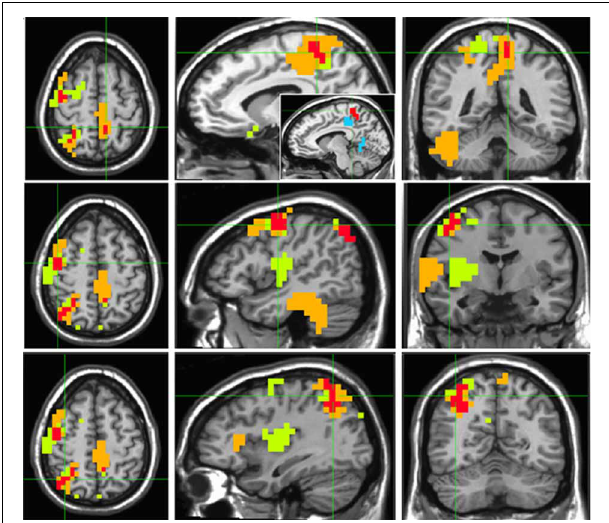
FIGURE 5 | Beamforming source estimates for the overlap between Then vs. Now and There vs. Here contrasts in the theta (4–8Hz) frequency. Axial, sagittal, and coronal views (left to right) of group ( n = 11) SAM pseudo- F source estimates overlayed on the Colin template. Note that in all images right and left sides are crossed. Green, orange and red indicate Then, There and overlap between conditions, respectively. Top : left paracentral lobule and precuneus (cluster 3, Table 3 ). In the sagittal view, the same cluster (red) is compared with left cingulate/precuneus activity (cyan) for the Timelesness/Spacelessness overlap (cluster 2, Table 3 ). Note the clear separation between the superior cluster found in the Then/There overlap, and the inferior cluster found for the Timelesness/Spacelessness overlap; Center : right precentral and middle frontal gyrus (cluster 2, Table 3 ); Bottom : posterior parietal lobule (cluster 1, Table 3